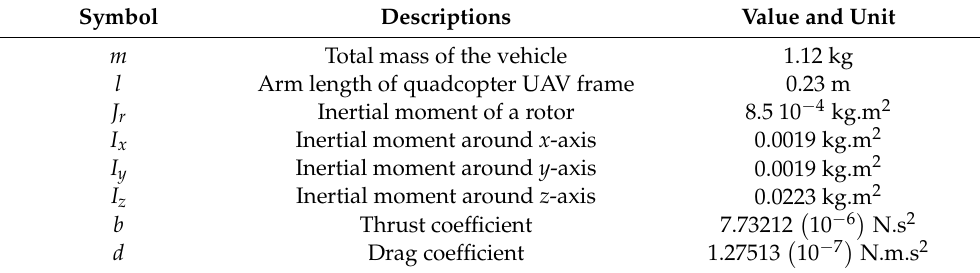
Table 1. System parameters of a quadcopter UAV.